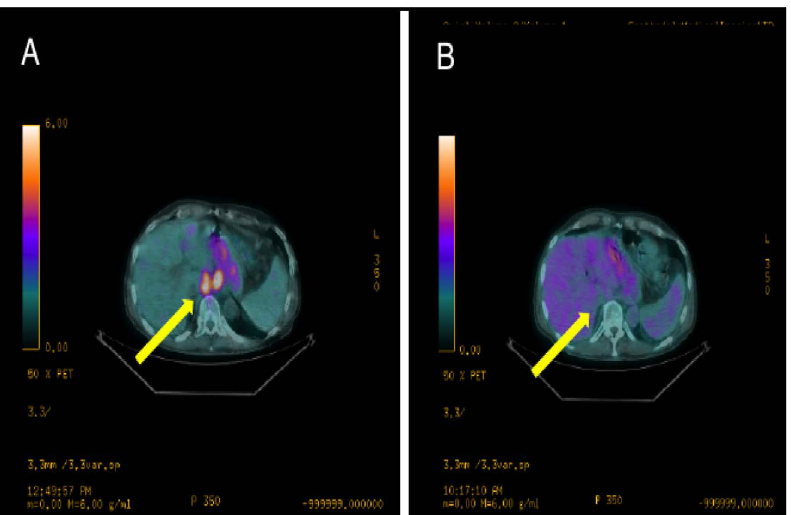
Figure 2. Patient 9 PET/CT images. 18-fluorodeoxyglucose positron emission tomography/computed tomography (PET/CT) images depicting (A) axial slice at baseline and (B) axial slice after 30 days on treatment. The yellow arrow is pointing to two hypermetabolic lymph nodes in B and C. In B, the standard uptake value (SUV) of the left lymph node is 9.8 and the lymph node on the right is 7.5, while the SUV of the left lymph node is 3.1 and the lymph node on the right is 3.5 in C.